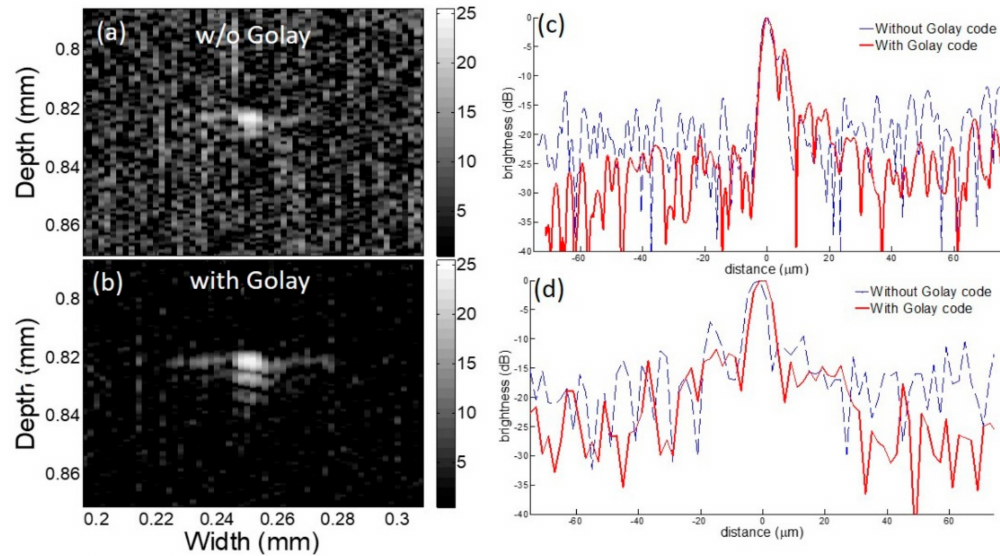
Figure 6. Wire target study results with 312 MHz imaging frequency: B-mode images are acquired with the proposed analogue frontend ( a ) without coded excitation and ( b ) with coded excitation. The brightness profiles in the dB scale represent ( c ) axial profile and ( d ) lateral profile. Note that the red solid and blue dashed lines represent the profiles with Golay and without Golay, respectively. Note that the scale of the gray bar is decibel